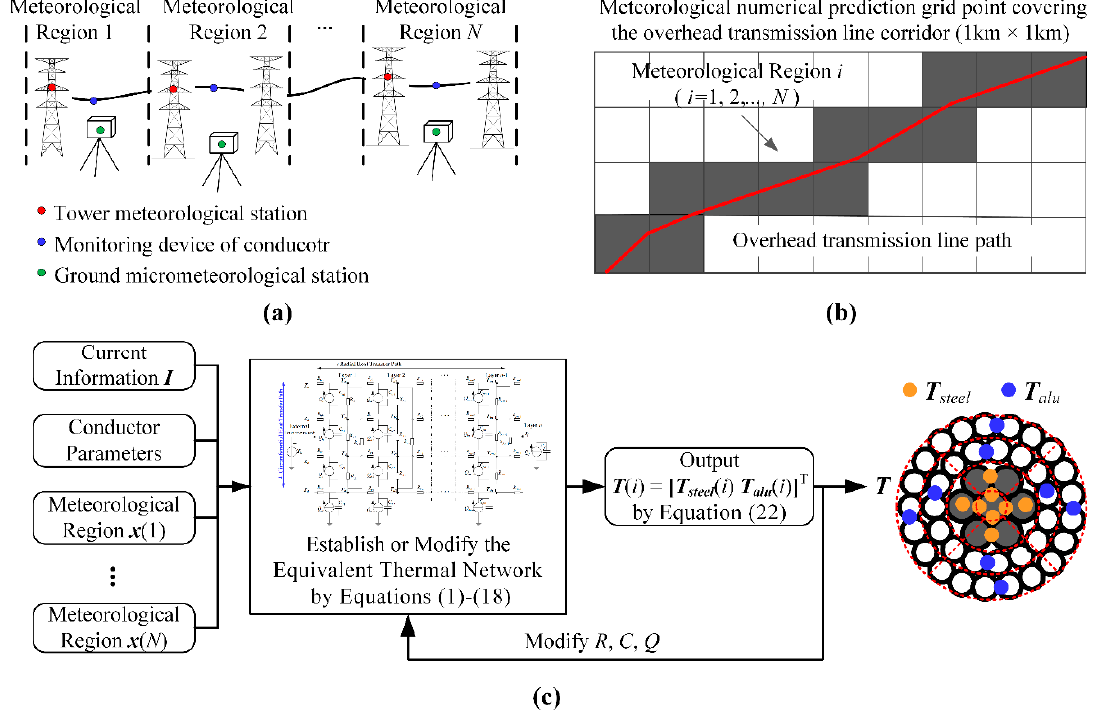
Figure 9. Transient temperature estimation of overhead transmission lines. ( a ) Acquisition of real-time meteorological parameters of each segment by on-line monitoring devices; ( b ) Acquisition of real-time meteorological parameters of each segment by refined numerical weather forecast; ( c ) Real-time feedback calculation and modification based on the ETN.